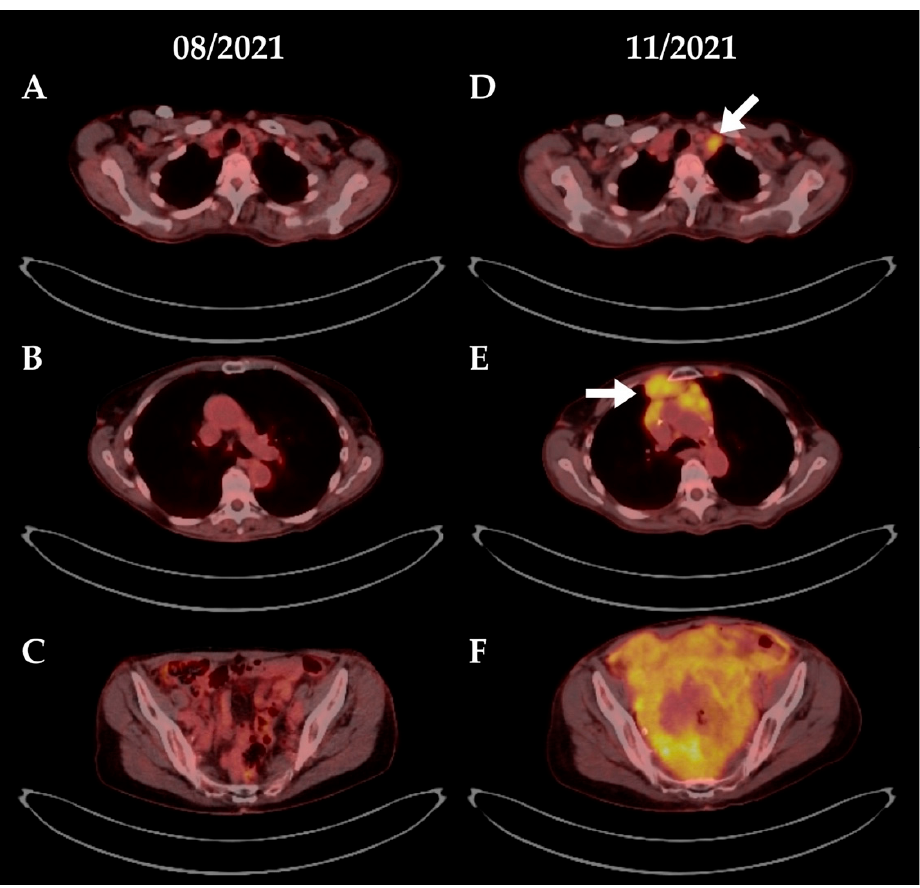
Figure 4. PET/CT scans of patient #2. Relapse after CAR T therapy. Three months after CAR T reinfusion, the patient achieved a complete metabolic remission (panels A – C ). Six months after infusion, PET/CT revealed extensive nodal (panel D and E , white arrows) and diffuse extranodal (pleural and peritoneal, panel F ) lymphoma manifestations. Treatment with R-bendamustine and then glofitamab was initiated. However, the patient denied further treatment and succumbed to pneumonia and disease progression around 3 months after glofitamab administration.